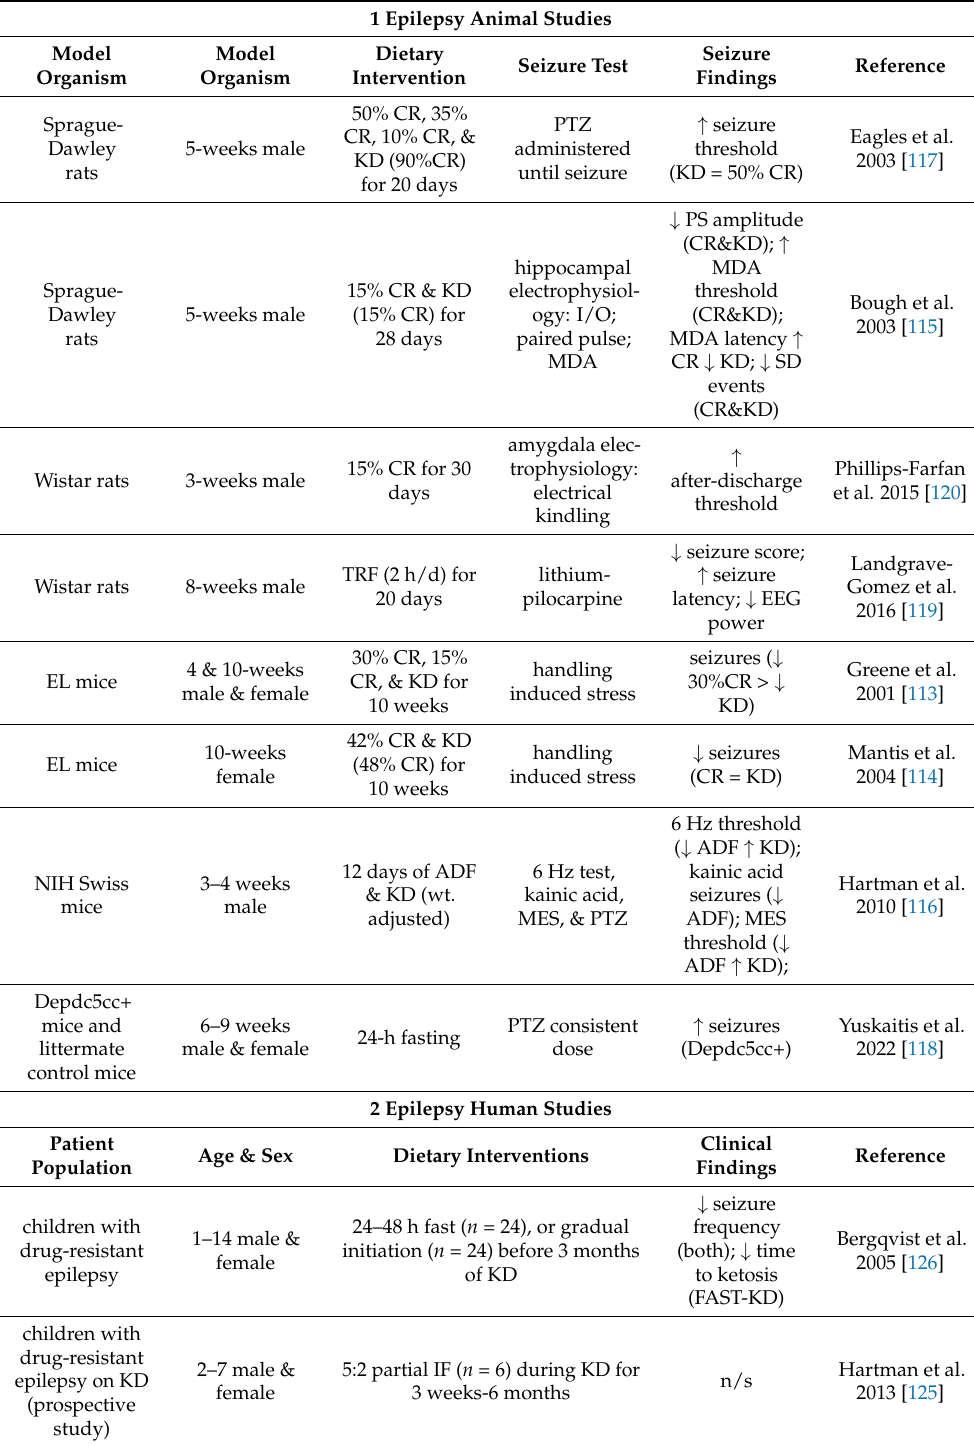
Table 3. All reviewed studies investigating the effects of DR in Epilepsy. N/A: relevant data not re- ported; n/s: relevant data not significant; PTZ: pentylenetetrazol; I/O: input/output; MDA: maximal dentate activation; PS: population spike; EEG: electroencephalogram; MES: maximal